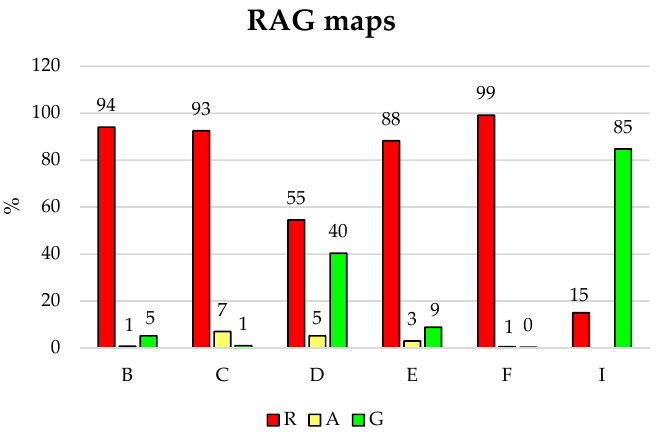
Figure 11. Histograms showing the percentages for each factor suitable for burial site in the RAG maps. Legend: R: Red code, A: Amber code, G: Green code. Factors for each RAG map: B—Diggability, C—Landscape/Slope, D—Vegetation, E—Human-Made Structures, F—Geomorphology, I—DSM-Visibility. Limits and Exit-Entry Points of the Search Area